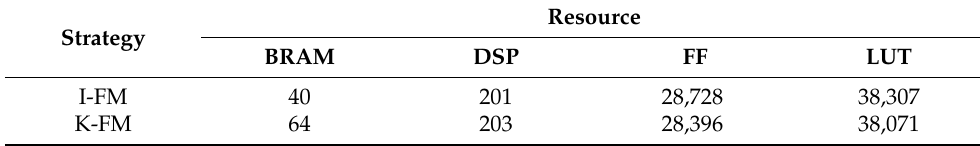
Table 3. Resource utilization under different SVM mapping strategies.